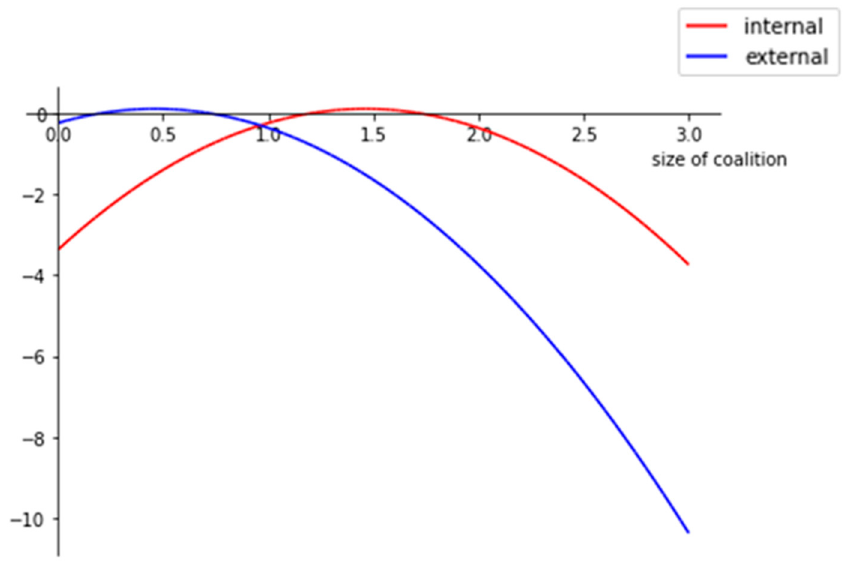
Figure 4. Only the grand coalition is stable—Corollary 3. Table 1. Summary of stability